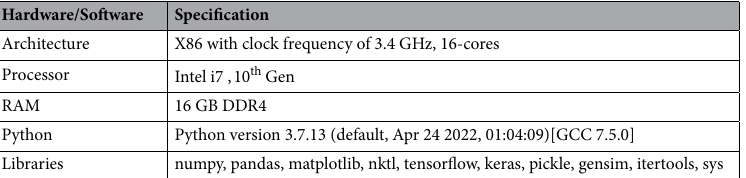
Table 2. Details of Hardware and Software used for Simulation.